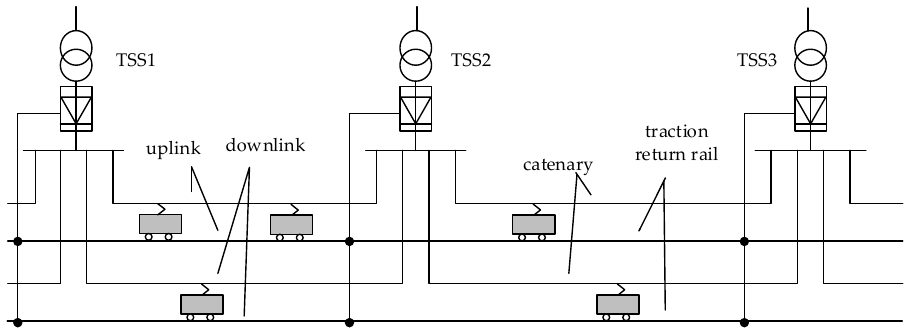
Figure 1. Schematic diagram of the urban rail transit power supply system. TSS, traction substation.